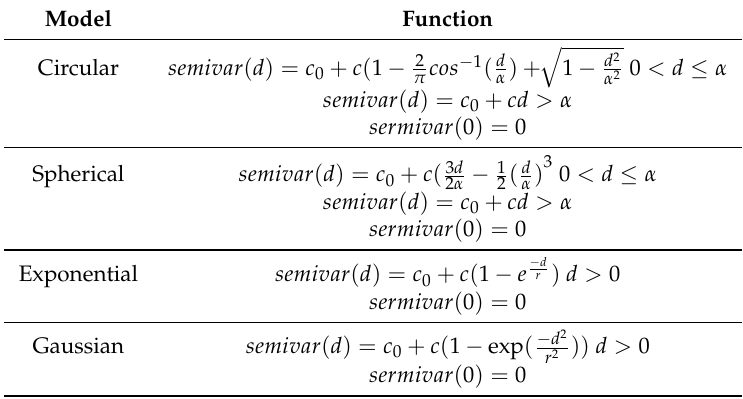
Table 3. Available Pollutants for each Data